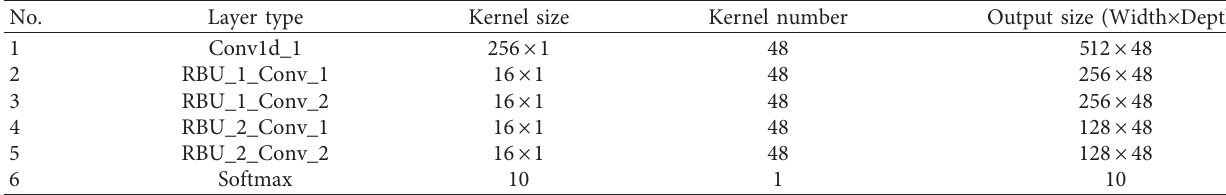
Figure 8: Accuracy of all methods under different noise intensities. Table 6: The network parameters of the 1D-WDRSN